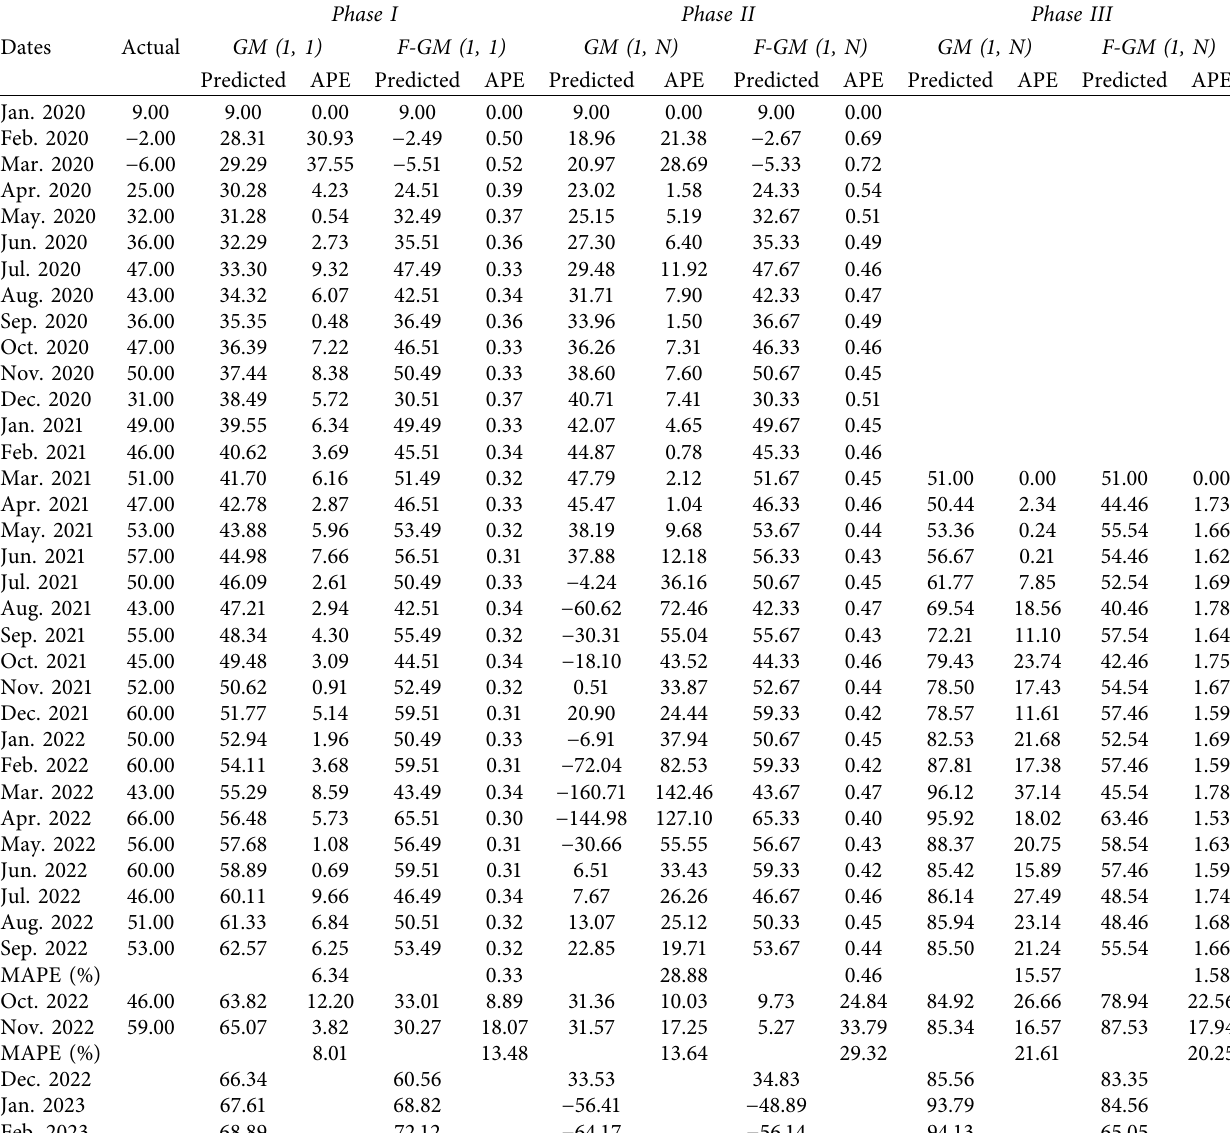
Table 11: Prediction results of travel sentiment in